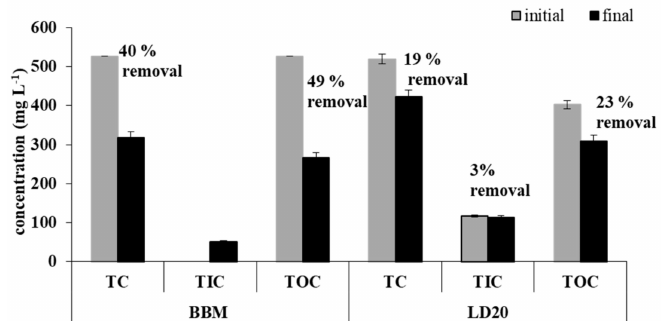
Figure 3. Initial and final concentration as well as the rate of removal of total carbon (TC), total organic carbon (TOC), and total inorganic carbon (TIC) by A. protothecoides from BBM medium and liquid digestate (LD